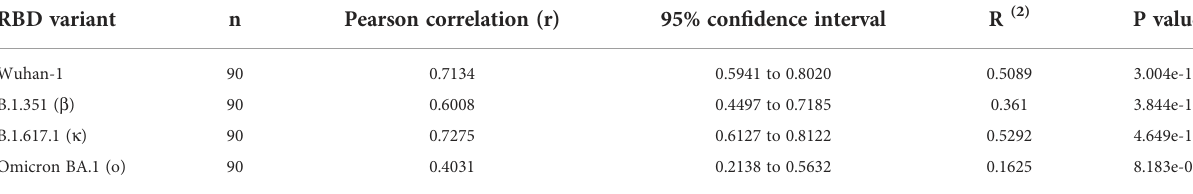
TABLE 1 Correlation analyses between anti-RBD IgG antibody levels present in serum samples and their neutralizing capacity. RBD